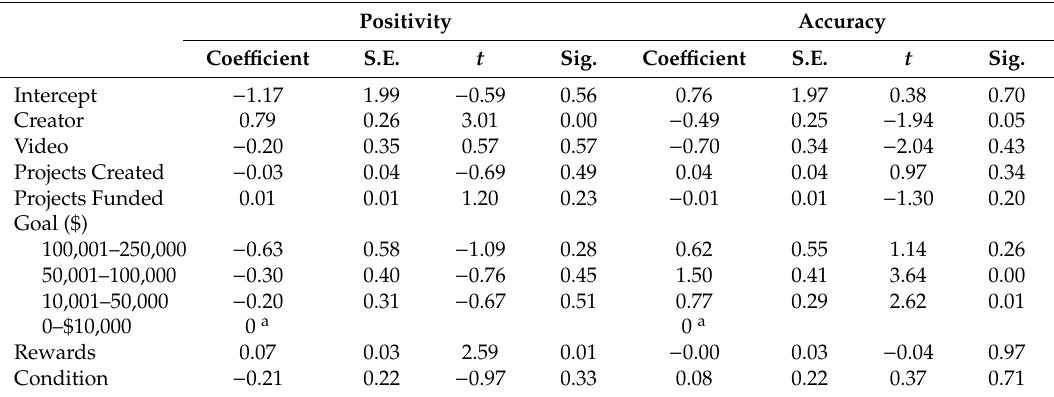
Table 3. Generalized linear mixed model (study 1, N =